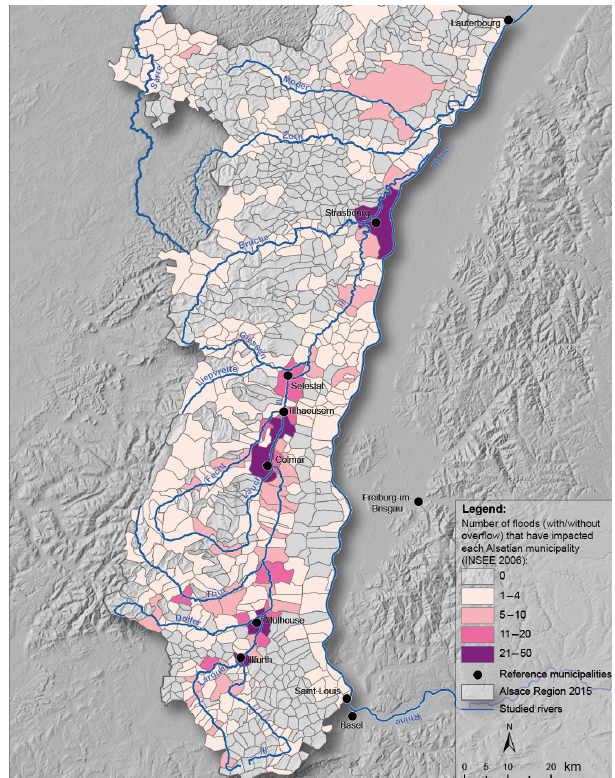
Figure 6. Total number of flood events per municipality. For each event, only the municipalities in which water overflow was reported are considered. Most of the overflows concern the 13 rivers specif- ically studied in this work, but a few correspond to other rivers (smaller rivers and/or rivers with fewer than 10 flood events in the ORRION